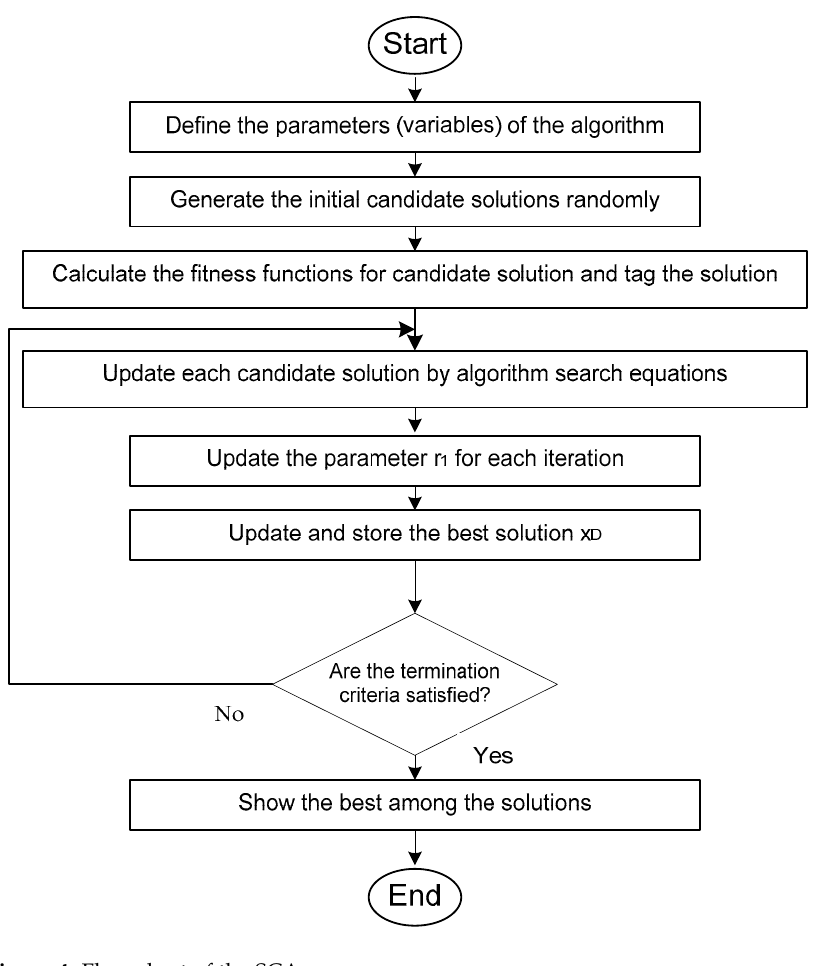
Figure 4. Flow chart of the SCA.